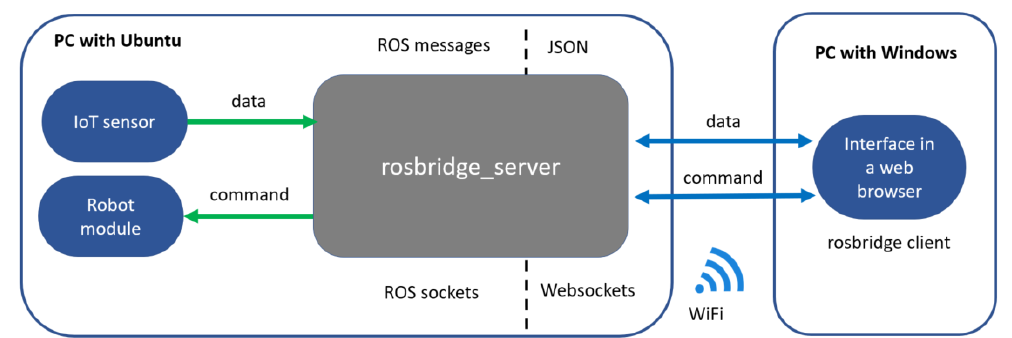
Figure 2. Simple application using a bridge server to connect Robotics and IoT components. The user interface and robot components are executed in different machines. This can introduce delays due to saturation of the WiFi connection and robustness issues of the Client/Server pattern.